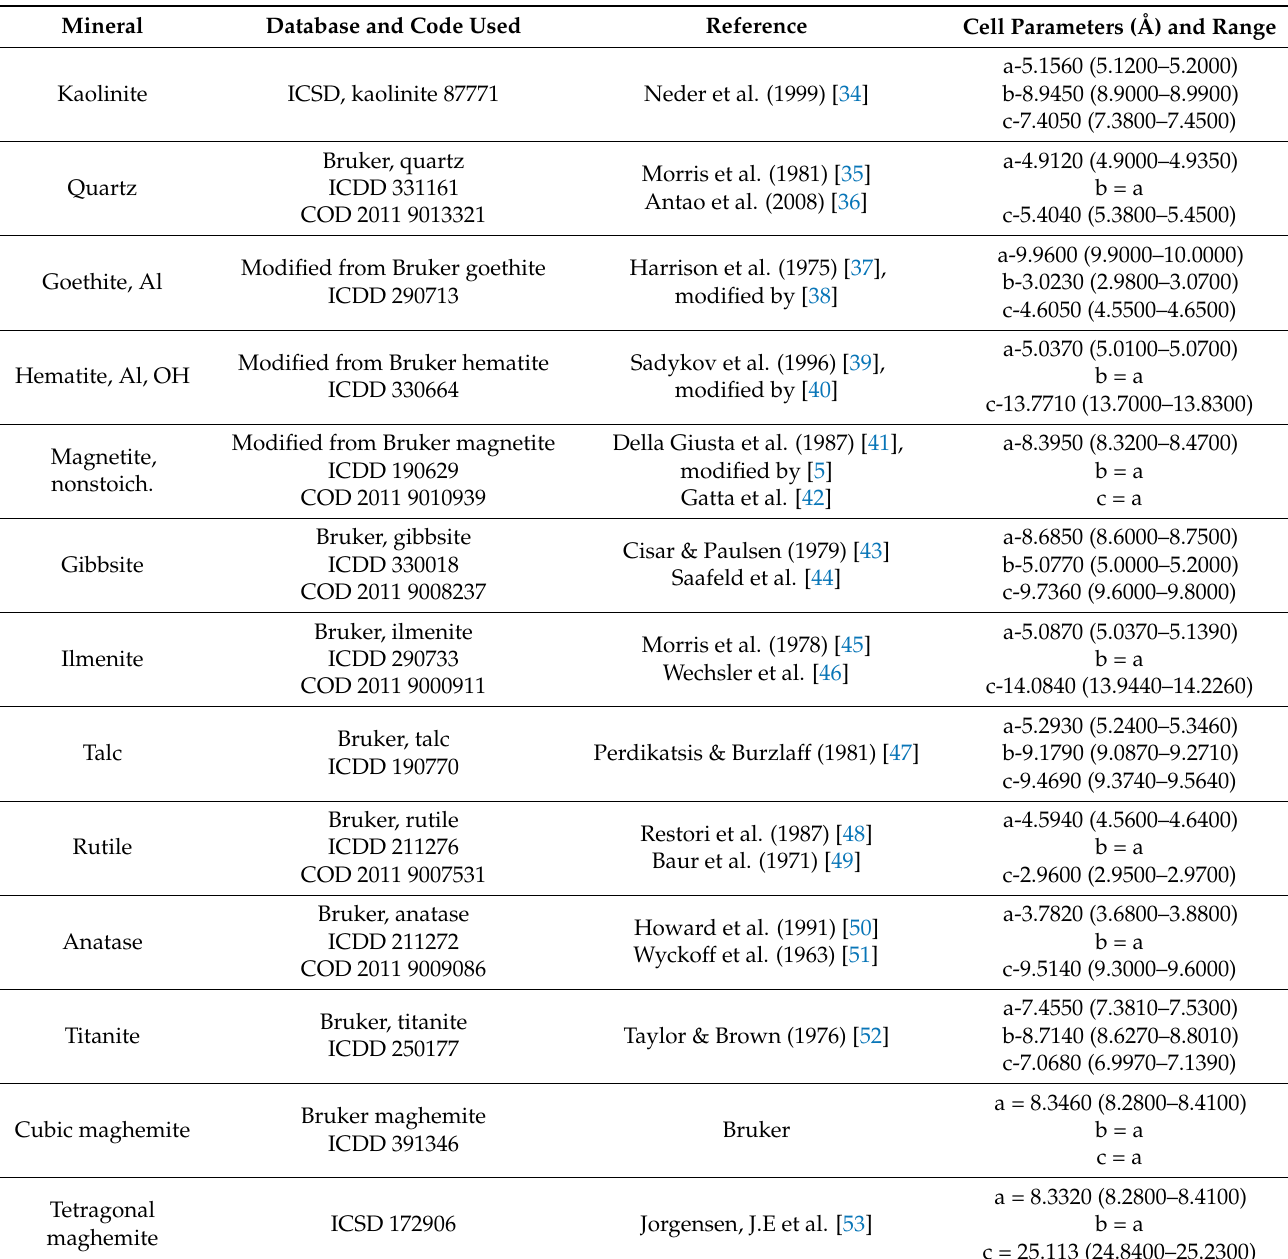
Table 1. Crystal structures used for the